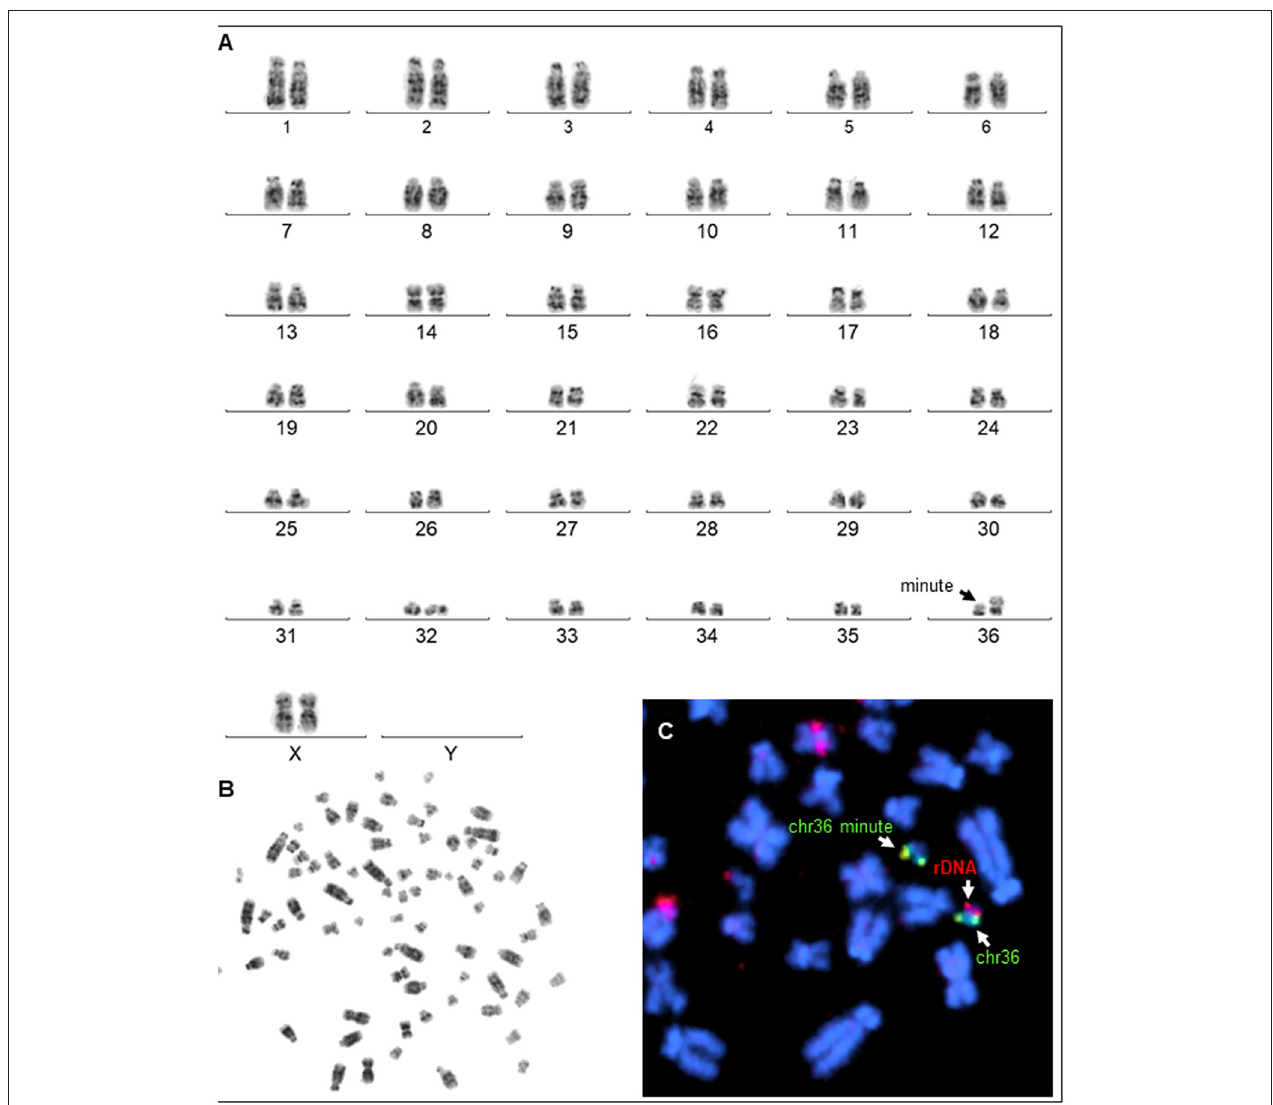
FIGURE 4 | Karyotyping. (A) G-banded karyotype (74, XX, m) of a female alpaca with a minute chromosome (arrow showing size difference between homologs of chr36). (B) Corresponding metaphase spread. (C) Partial metaphase showing (arrows) FISH results with chr36 specific probe (green) and the presence of ectopic rDNA (red) in the larger